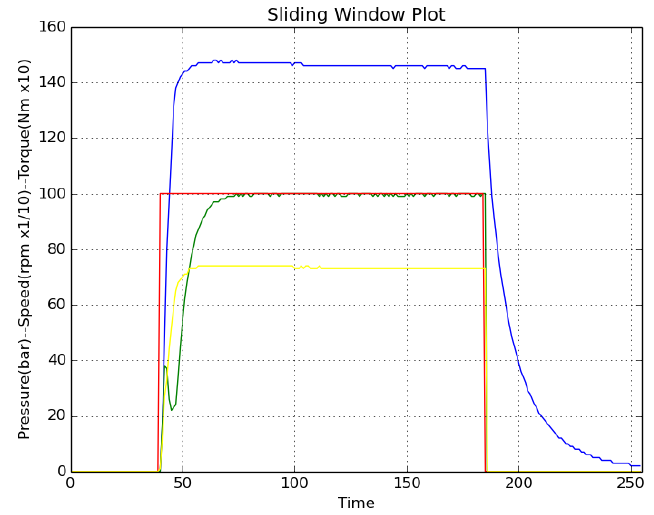
Figure 14. Pump running at 1000